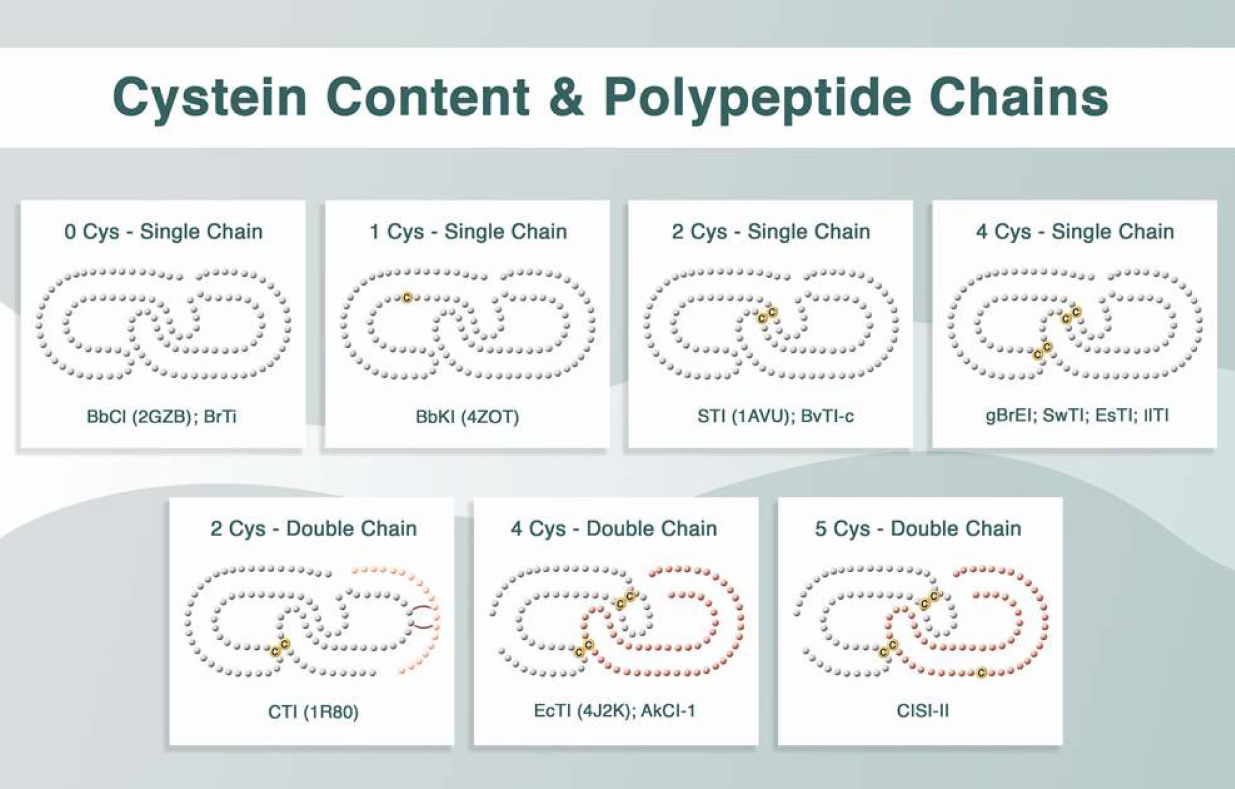
Figure 1. Structural aspects of plant Kunitz inhibitors in terms of the number of cysteine residues (0, 1, 2, 4, or 5 Cys), S–S bridges (none, intrachain and/or interchain bridges), and polypeptide chain representation (single or double